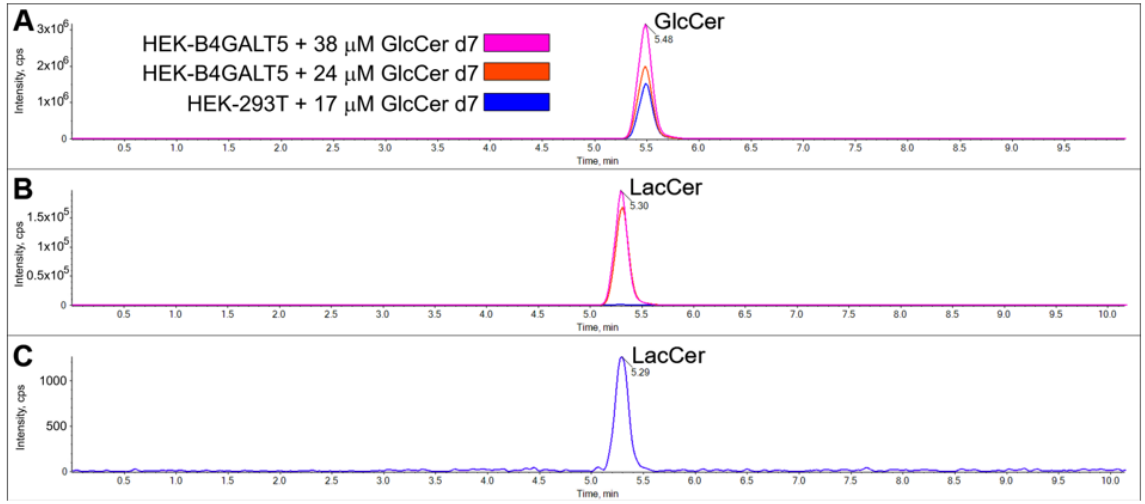
Figure 5. Detection of LacCer synthase activity by the novel method using deuterated glucosylceramide (GlcCerd7). The enzymatic conversion to lactosylceramide (LacCerd7) was monitored by LC-MS/MS. Comparison of GlcCerd7 ( A ) and LacCer ( B ) profiles in HEK-B4GALT5 and HEK-293T cells. Since it appears as a baseline with the scale used in this last case, it is presented alone in panel ( C ) with a different scale. To obtain these chromatograms, various amounts of GlcCerd7 with 0.15 mg/mL of cell homogenate (expressed as proteins) were incubated for 60 min. Note the different scales used in each panel; cps, counts per second.